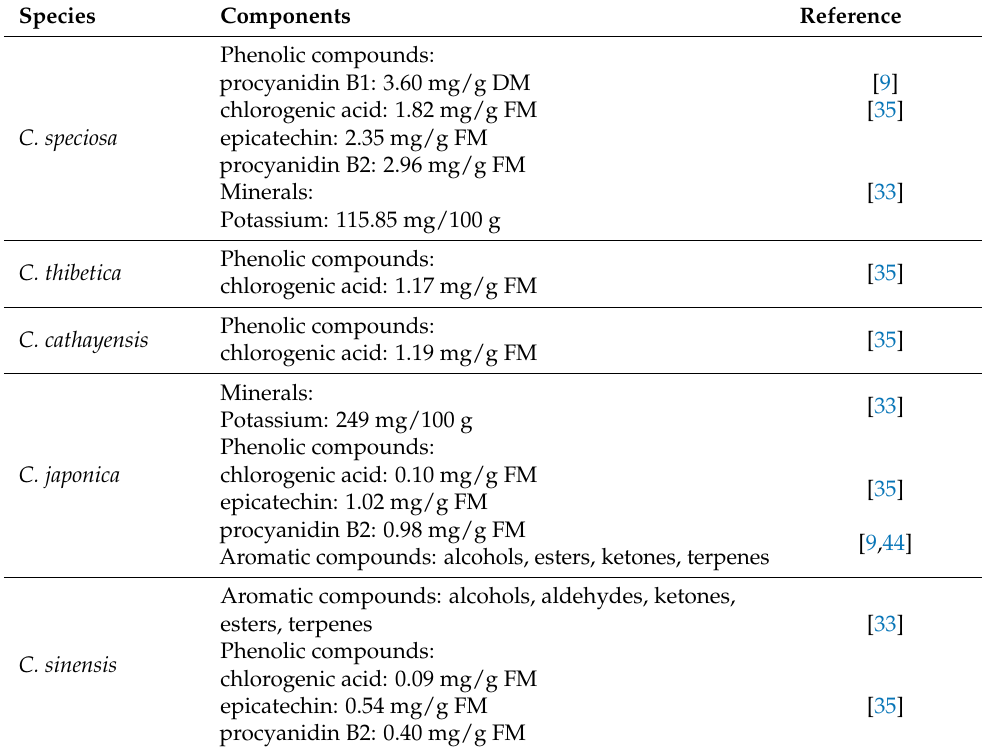
Table 1. The content of selected compounds in Chaenomeles sp.